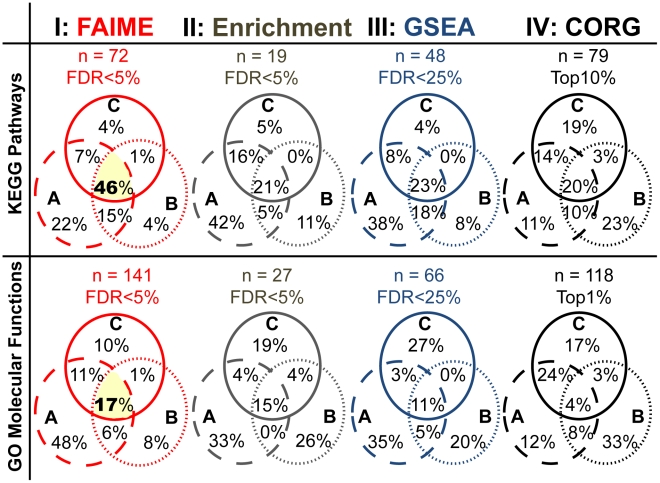
Reproducibility of molecular pathways and functions derived using FAIME as compared to three conventional enrichment methods.To establish that FAIME profiles reliably yield functionally overlapping mechanisms across independent datasets for the same phenotype, we compared the deregulated GO-MF and KEGG FAIME Scores to conventional enrichment studies (hypergeometric enrichment test, GSEA and CORG). The resultant predictions for each method are plotted in their respective columns for both KEGG (top plots) and GO Molecular Function (bottom plots) terms. The letters A, B, and C represent the three analyzed HNSCC microarray datasets (Table 1). Each functional analysis method is independently applied to each dataset and their predicted results are compared in Venn diagrams. FAIME derived features are the most consistent with 47% to 61% KEGG overlap and 18% to 28% GO-MF overlap between any two datasets. In comparison, the next best method in each case provided 23% to 41% KEGG overlap (GSEA) and 15% to 19% (Enrichment). These functional overlapping ranges are well above those generally reported across distinct, yet related, datasets at the gene level [7], [9], [43]. An FDR of 5% is used for FAIME and enrichment results. GSEA is originally reported with a FDR<25% [18] and thus we present its cutoff at a FDR = 25% where overlap is better than for lower FDRs (we observed fewer overlapping GSEA results among the three studies at a 5% FDR). CORG does not report data with p-values or FDRs [27] and the absolute cutoffs presenting the number (n) of resultant KEGG pathways and GO-MF are in a range comparable to that of other methods (Top 10% of KEGG, Top 1% of GO-MF). The 57 Oncogenic FAIME Features of HNSCC (highlighted in yellow, see Methods) that are common to all three HNSCC datasets shown above, 33 KEGG terms (46%) and 24 GO terms (17%) obtained by FAIME (Table S1), are used as seeds for validation studies in three other independent datasets for which the results are shown in Figures 5–6.